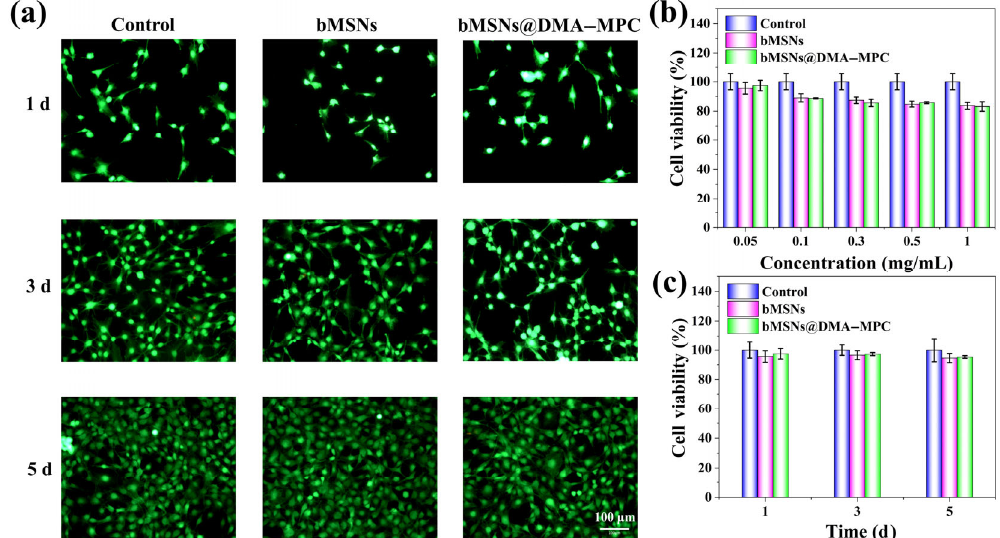
Fig. 9 In vitro cell cytotoxicity evaluation of the bMSNs and bMSNs@DMA–MPC (1:4) nanoparticles. (a) Representative laser scanning confocal microscopy images showing the MC3T3-E1 cells incubated with the nanoparticles for 1, 3, and 5 d, as determined by the live/dead staining assay. CCK-8 assay result showing cell viability of the MC3T3-E1 cells incubated with the nanoparticles at (b) different concentrations and (c) different time